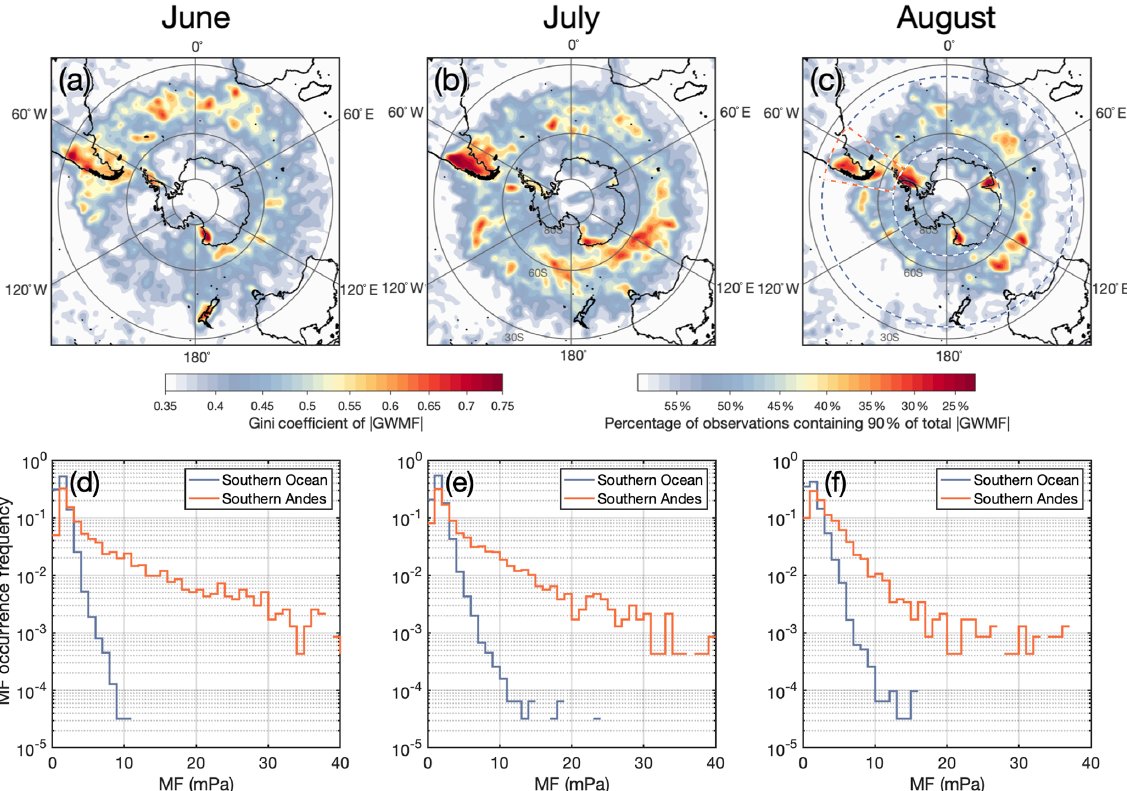
Figure 9. Panels (a, b, c) show the Gini coefficient of absolute gravity wave momentum flux (GWMF) for each month of AIRS measurements at z = 40km for June, July and August 2010. One colour bar shows the value of the Gini coefficient, while the other shows the corresponding fraction of wave events attributable to 90% of the total monthly absolute GWMF. The same colour scale and limits are used such that both properties directly correspond. Orange and grey dashed lines in (c) show regions defined over the southern Andes and Southern Ocean, as used in Table 2. Probability density functions (PDFs) of GWMF at z = 40km over these regions for the corresponding months are shown in panels (d, e, f)